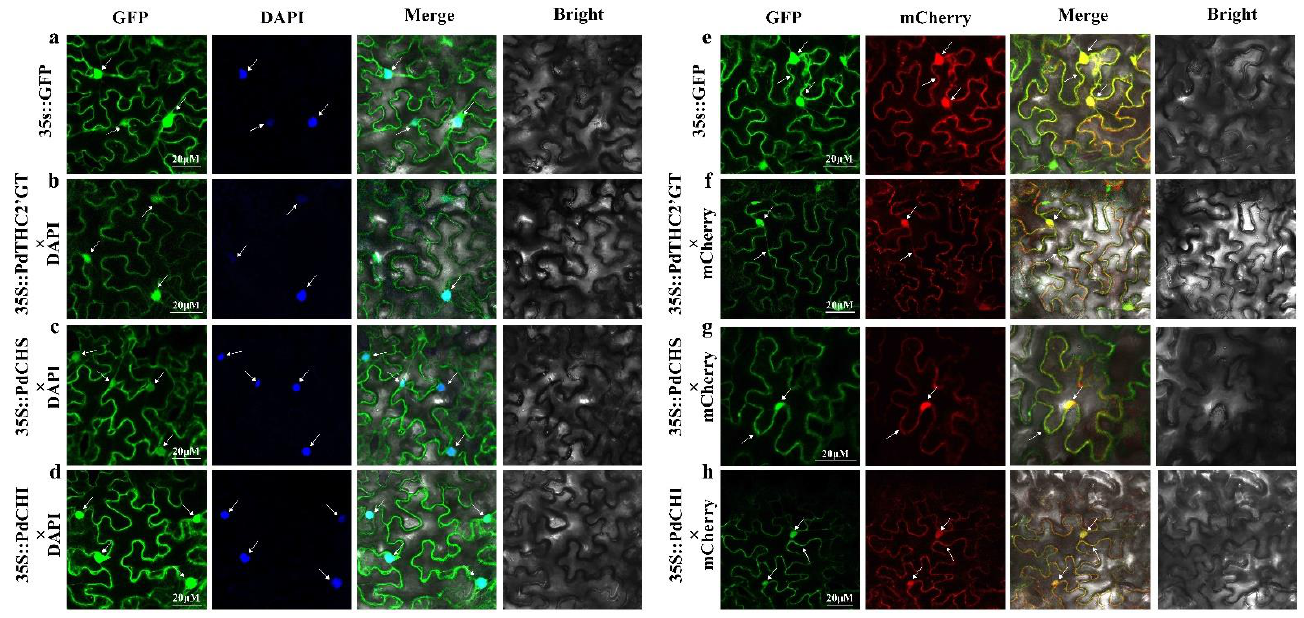
Figure 5. Subcellular localization of PdTHC2′GT , PdCHS, and PdCHI in Nicotiana benthamiana . ( a ) Subcellular localization in N. benthamiana infected with 35S::GFP and DAPI. ( b ) N. benthamiana in- fected with 35S::PdTHC2′GT-GFP and DAPI. ( c ) N. benthamiana infected with 35S::PdCHS-GFP and DAPI. ( d ) N. benthamiana infected with 35S::PdCHI-GFP and DAPI. ( e ) N. benthamiana infected with